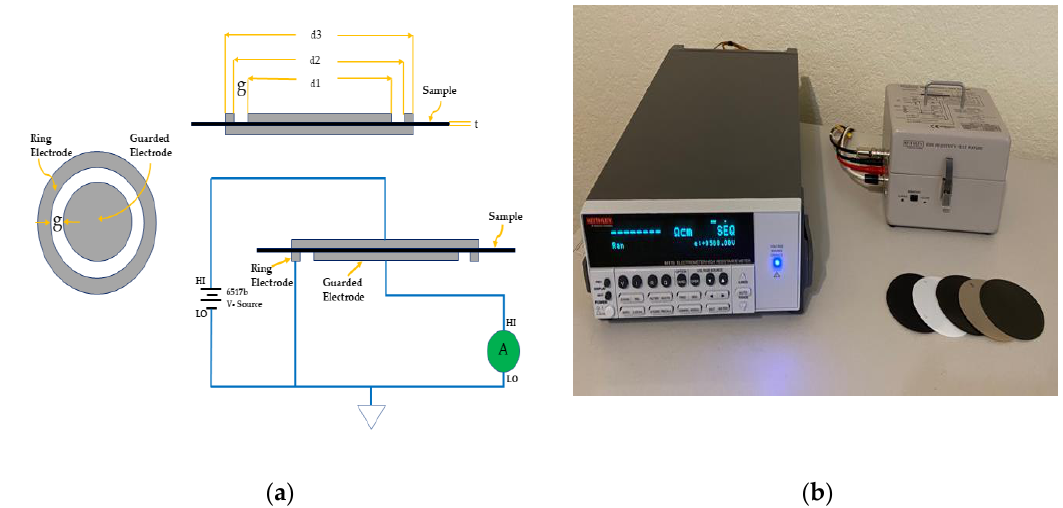
Figure 2. ( a ) Schematic of a typical electrometer resistivity test; ( b ) resistivity measurement setup 2 (Keithley 6517b + 8009).